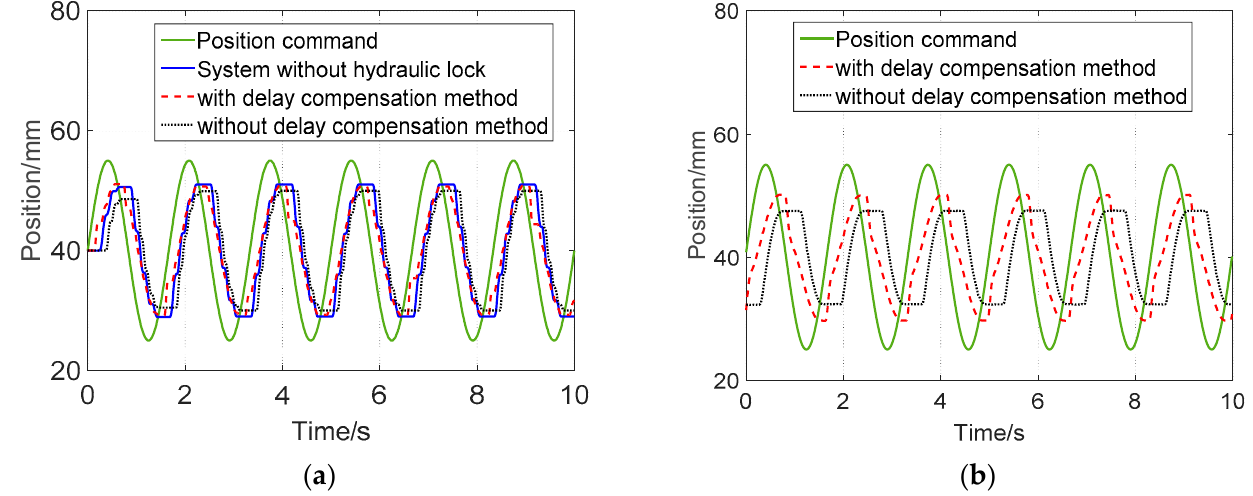
Figure 26. The simulation and the experimental results of the system using the delay compensation method with a typical PI controller and with the EHA system without the hydraulic lock. ( a ) the simulation results. ( b ) the experimental results.